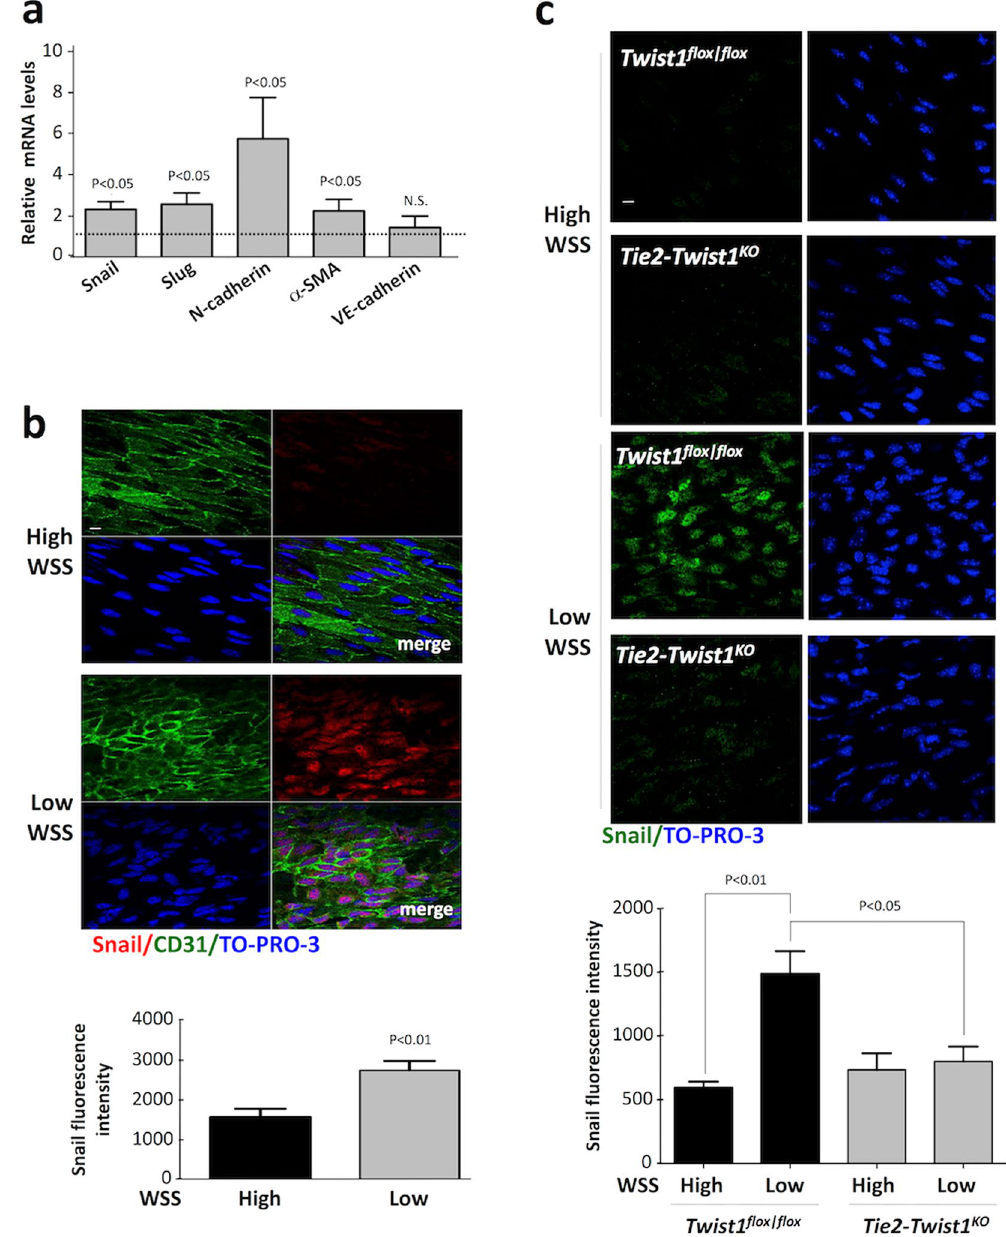
Figure 4. Snail was preferentially expressed at low shear atherosusceptible sites. ( a ) EC were freshly-isolated from low wall shear stress (WSS; inner curvature) and high WSS (outer curvature) regions of the aorta in six pigs. Levels of Snail, Slug, N-cadherin, α -SMA and VE-cadherin mRNA were quantified by qRT-PCR. The expression level at the low WSS site is presented relative to the expression at the high WSS site (normalised to 1; dotted line). Mean levels + / − SEM are shown. ( b , c ) EC at low WSS (susceptible) or high WSS (protected) regions of the aorta were studied by en face staining. ( b ) C57BL/6 mice (n = 5) were stained using anti-Snail antibodies (red), co-stained using anti-CD31 antibodies (green) and counterstained using TO-PRO-3 (DNA; blue). ( c ) TWIST1 cKO or TWIST1 fl/fl mice (n = 4 each group) were stained using anti-Snail antibodies (green) and counterstained using TO-PRO-3 (DNA; blue). Representative images (scale bar, 10 μ m) and quantitation of Snail fluorescence levels (mean + / − SEM) are shown. Differences between means were assessed using a paired t-test ( b ) or two-way ANOVA ( c